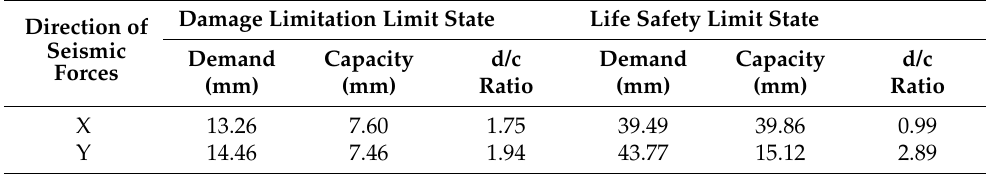
Table 7. Seismic capacity and seismic demand displacements for the model of the main building. Direction of Seismic